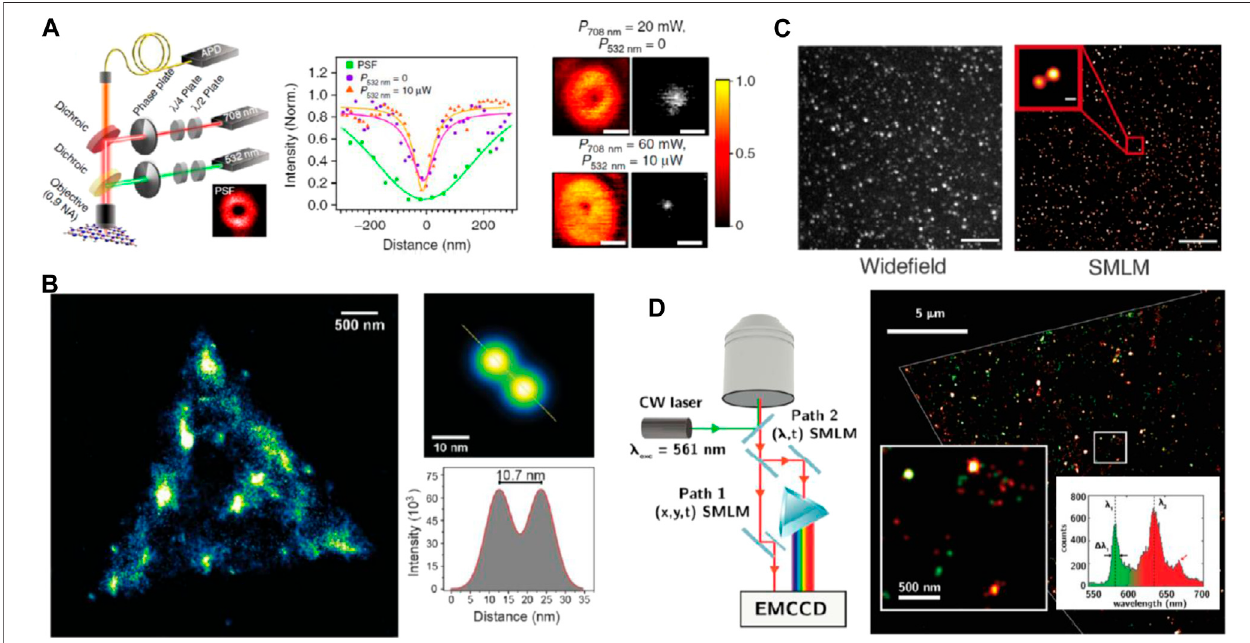
FIGURE 2 | RESOLFT and SMLM microscopy in hBN. (A) Super-resolution microscopy using dual torus-beam excitation. Left: schematics of the experiment. Center: point spread function of the confocal system (green), and resolutions obtained under 708 nm torus-beam laser excitation only (violet) and adding a second 532 nm torus-beam (orange). Right: the resolution increases upon increasing the intensity of both the 708 nm and the 532 nm lasers. (B) SMLM imaging of optically active defects in hBN reconstructed from an image sequence of 20,000 frames, display pixel size: 1 nm. With drift correction using fi ducial markers, the method achieves a resolution of 10.7 nm (C) Wide fi eld and SMLM reconstructed image (based on 6,000 frames) of an ensemble of hBN nanoparticles (average size (3.0 ± 0.7) nm), synthesized by cryo-exfoliation (scale bar: 5 μ m). Inset: zoomed-in section showing two emitters in the super-resolved image (scale bar: 100 nm). (D) Multimodal SMLM. Left: schematics of the experiment showing dual spatial and spectral detection. Right: Spatial and spectral distribution of centers in a CVD-grown hBN fl ake. A dual spectral distribution is visible corresponding to green and red emitters with emission wavelength λ 1 and λ 2 (right inset). Figures adapted and reprinted with permission: (A) [64]CopyrightSpringerNature2018; (B) [141]CopyrightAmericanChemicalsociety 2018; (C) [87]CopyrightAmericanChemicalsociety 2019; (D) [65] Copyright American Chemical society